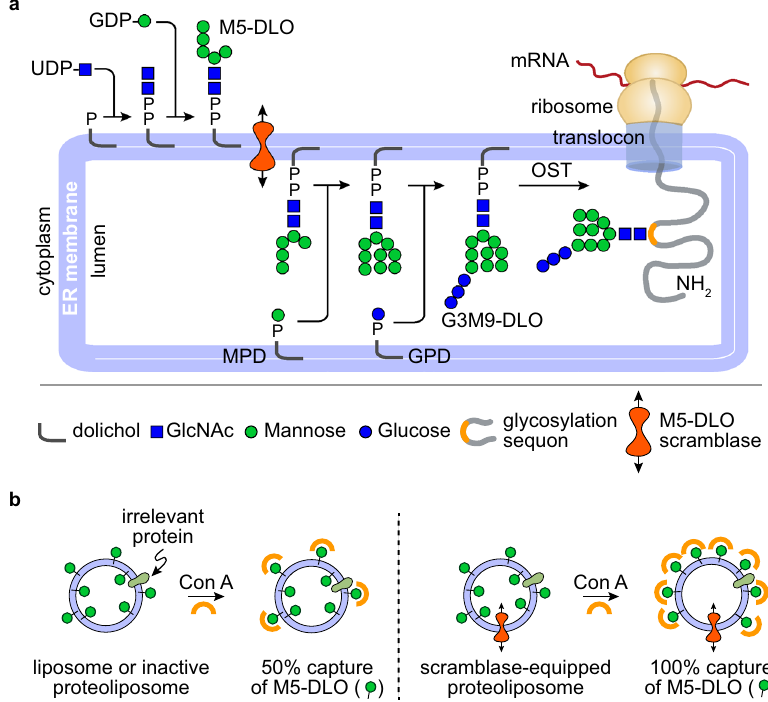
Figure 1. Transbilayer movement of Man 5 GlcNAc 2 -PP-dolichol (M5-DLO). ( a ) Synthesis of Glc 3 Man 9 GlcNAc 2 -PP-dolichol (G3M9-DLO), the oligosaccharide donor for protein N -glycosylation in yeast and humans, occurs in two stages. The first stage, comprising seven glycosyltransfer reactions, occurs on the cytoplasmic side of the ER to generate M5-DLO from dolichyl phosphate, UDP-GlcNAc and GDP-mannose. The remaining seven glycosyltransfer reactions occur in the ER lumen, adding four mannose residues (from mannose phosphate dolichol (MPD)) and three glucose residues (from glucose phosphate dolichol (GPD)) to M5-DLO to generate G3M9-DLO. The switch from the cytoplasmic to the lumenal side of the ER requires transbilayer movement of M5-DLO, which is facilitated by M5-DLO scramblase. The right side of the figure shows oligosaccharyl-transferase (OST)-mediated transfer of the Glc 3 Man 9 GlcNAc 2 oligosaccharide from G3M9-DLO to an asparagine residue within a glycosylation sequon in a nascent protein as it emerges from the protein translocon into the ER lumen. See text for details. ( b ) Recapitulation of M5-DLO scrambling in a reconstituted system. The assay exploits the organic-solvent-resistant interaction between M5-DLO and the lectin Concanavalin A (Con A)—thus whereas M5-DLO is soluble in organic solvent, M5-DLO/ConA complexes are precipitated. Proteoliposomes are reconstituted from egg phosphatidylcholine, [ 3 H]M5-DLO and ER membrane proteins. Protein-free liposomes are prepared in parallel. Incubation of protein-free liposomes with Con A results in the capture/precipitation of ~ 50% of [ 3 H]M5-DLO (left), corresponding to the pool in the outer leaflet of the vesicles, whereas similar incubation of proteoliposomes containing M5-DLO scramblase results in the capture of ~ 100% of [ 3 H]M5-DLO (right) as M5-DLO molecules in the inner leaflet are translocated to the outer leaflet where they are captured by Con A. Proteoliposomes reconstituted with proteins other than the M5-DLO scramblase, i.e. irrelevant proteins, are expected to behave similarly to protein-free liposomes